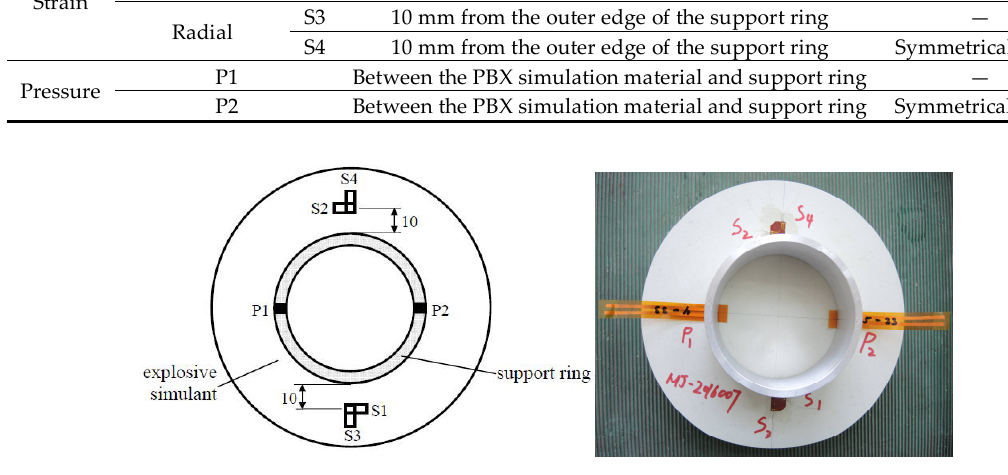
Figure 4. Location of measuring point.